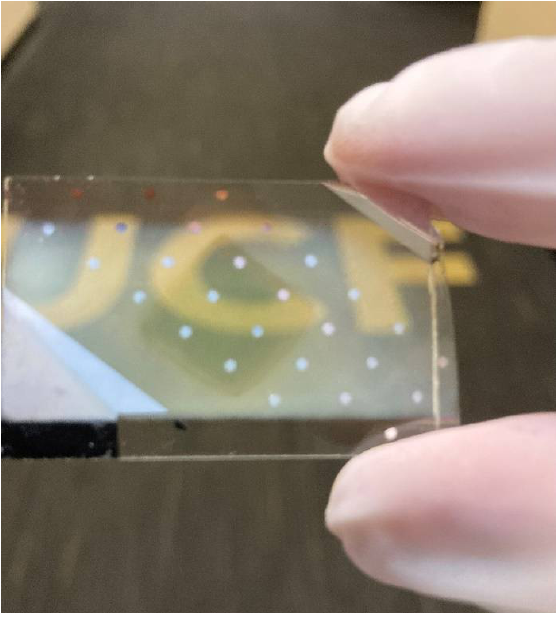
Figure 8. Photomicrograph of the fabricated device on a quartz substrate showing a high transpar- ency.